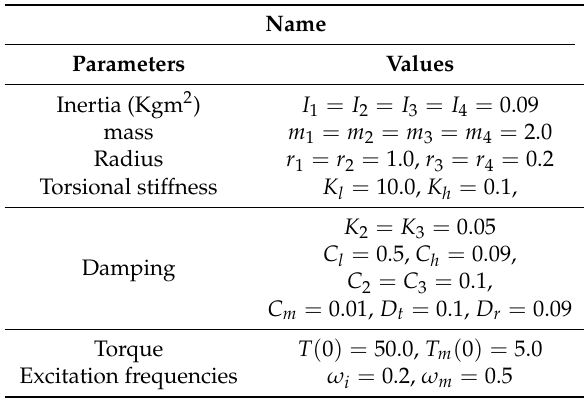
Table 2. Table of parameters for Figures